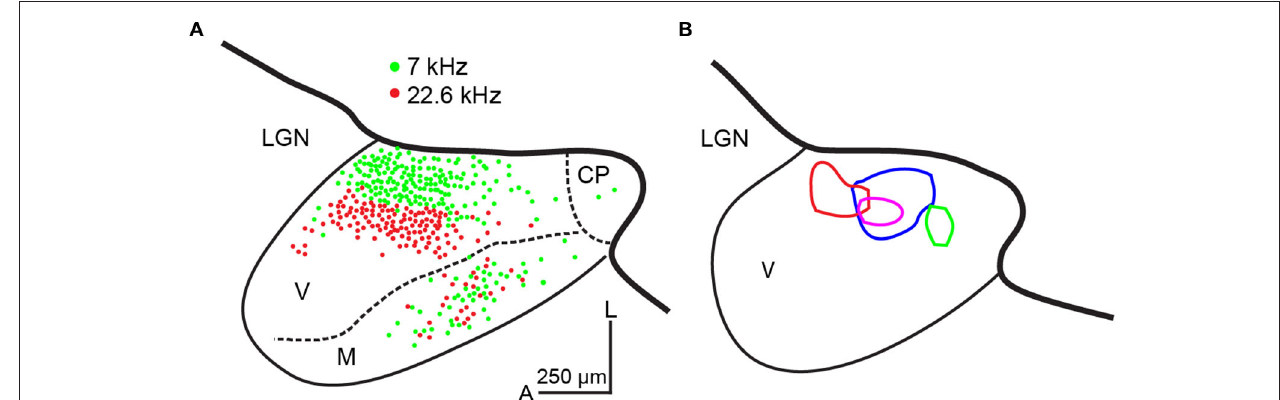
horizontal plane) of the MGB by laser-scanning photostimulation while making whole-cell recordings from layer 4 A1 neurons in the mouse. These examples illustrate convergence to single A1 neurons. CP: caudal pole, LGN: the lateral geniculate nucleus, M: medial division of the MGB, V: ventral division of the MGB, A: anterior, L: lateral. The scale bar in (A) is applied to (B) . To adjust scale of fixed tissue to live tissue, a factor of 1.4 is applied. Unpublished